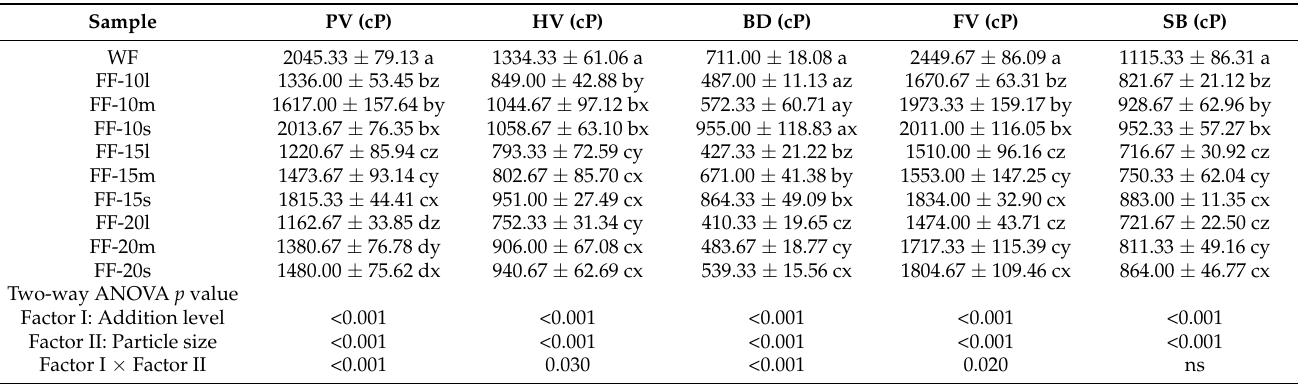
Table 2. Pasting properties of formulated flours influenced by different particle size distributions and addition